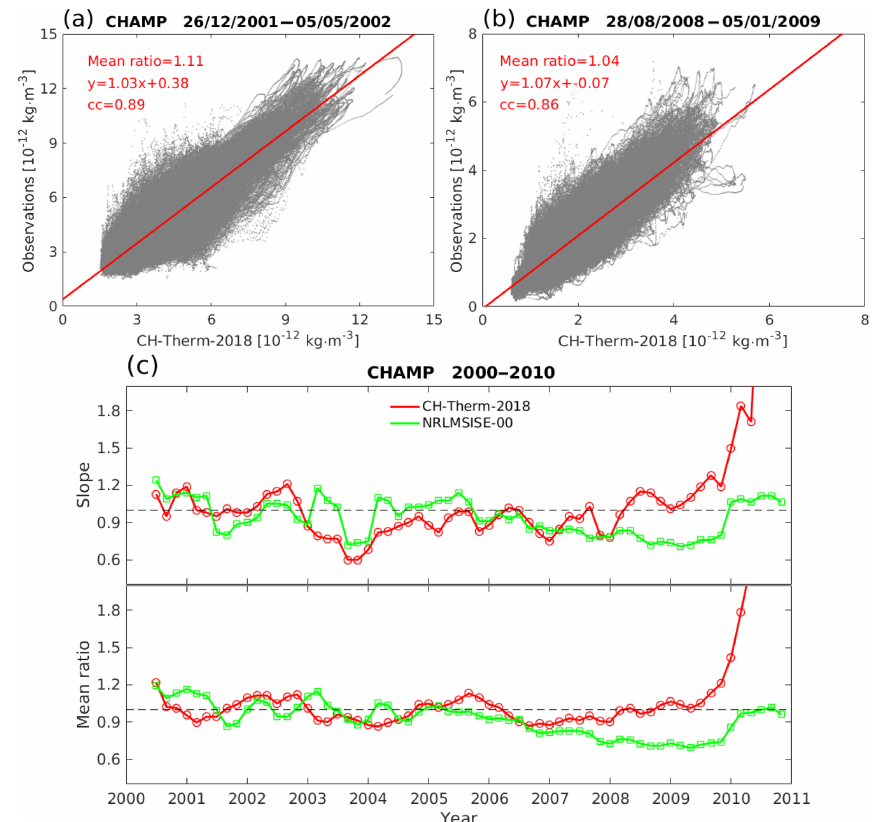
Figure 7. The linear regression between CHAMP observations and our model-predicted results during 131-day period (a) for high (centered on 1 March 2002) and (b) low (centered on 1 November 2008) solar activity conditions, respectively. (c) The red color shows the slope (top panel) and mean ratio (bottom panel) of the linear regression for each 2-month period from 2000 to 2010. The green color shows the results from NRLMSISE-00